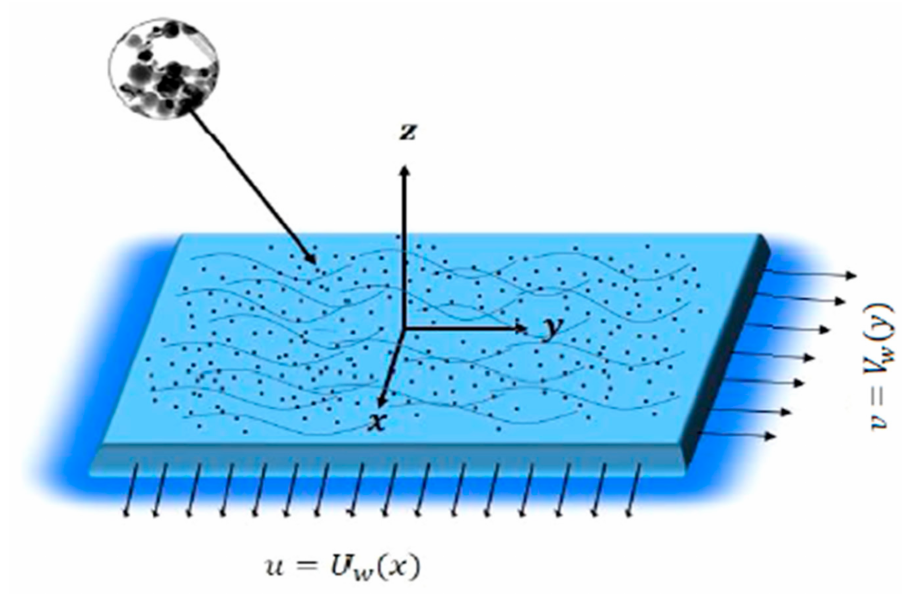
Figure 1. Geometry of the problem. Table 1. Thermo physical characteristics of nanoparticles (Zn, TiO 2 ) and base fluid, H 2 O.